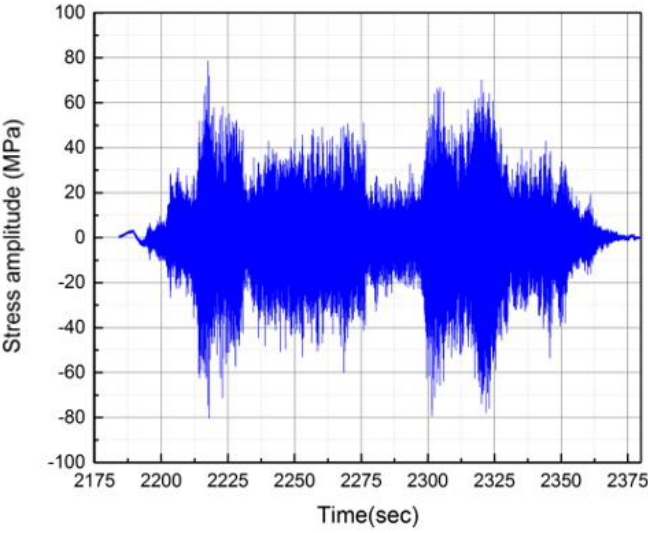
Figure 8. The stress waveform at point D02.